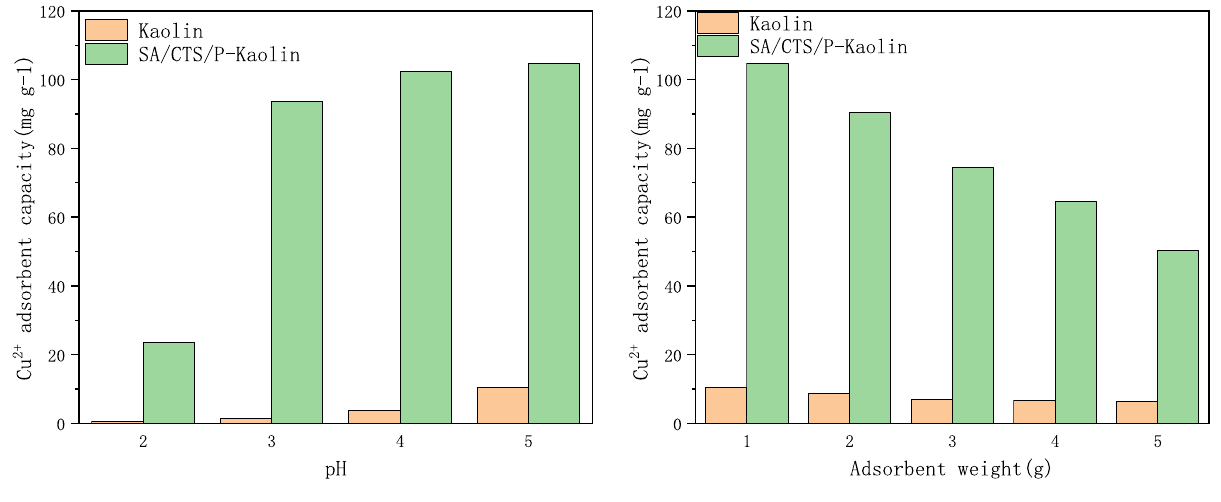
Figure 4: E ff ect of pH on Cu 2 + adsorption. Figure 5: E ff ect of adsorbent weight on Cu 2 + adsorption.